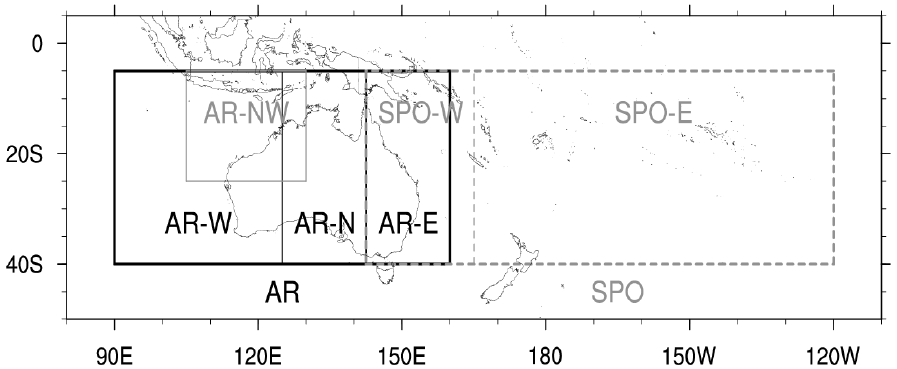
Figure 1. Study area: the Australian region (AR) and the South Pacific Ocean region (SPO), and their sub-regions: northwestern AR (AR-NW), western AR (AR-W), northern AR (AR-N), eastern AR (AR-E), western SPO (SPO-W), and eastern SPO